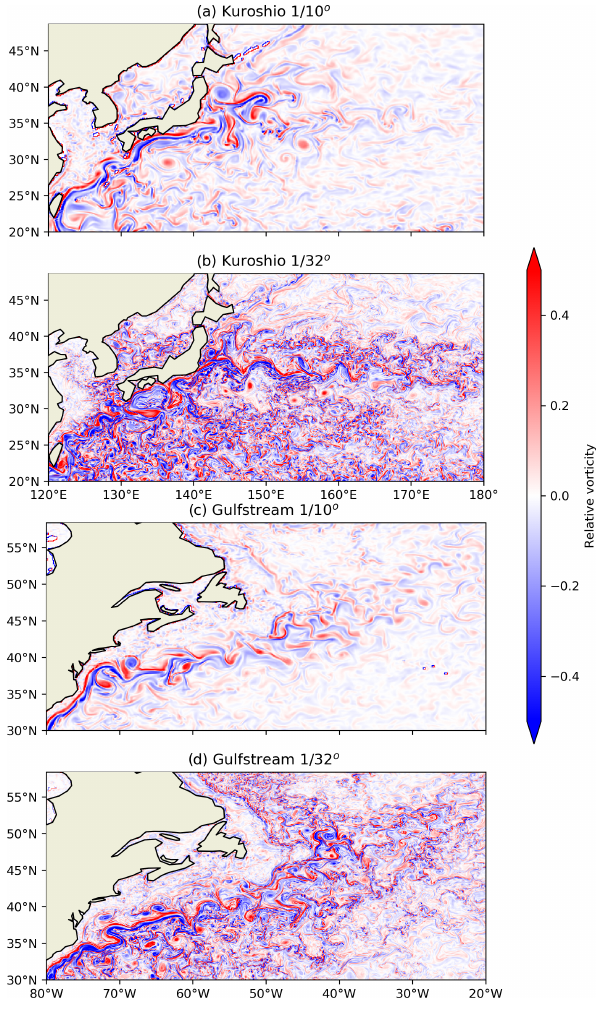
Figure 7. The same as Fig. 6 but for winter (1 March